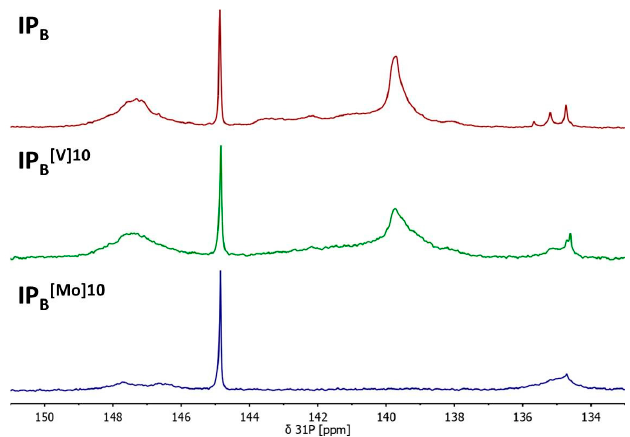
Figure 1. Comparison of the 31 P NMR spectra of starting IP B and residues isolated after treatment with the [V] -based catalyst system and the [Mo] -based catalyst system at 10% ( w/w ).